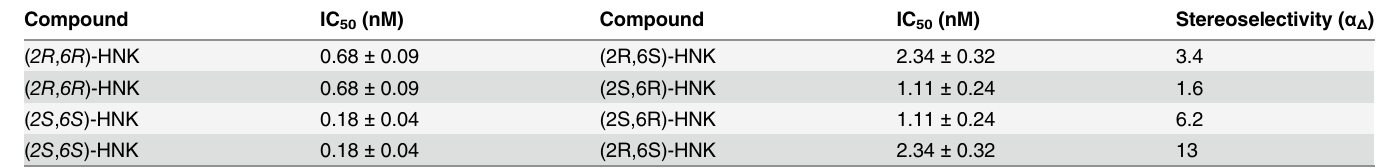
Table 2. The stereochemical configurations at the C2 and C6 carbons of hydroxynorketamine (HNK) affect the concentration-dependent decrease in intracellular D-Ser concentration in PC-12 cells. The relative pharmacological activity ( α D ) is derived by IC 50 ( trans -isomer)/IC 50 ( cis -isomer). The IC 50 values are expressed as means ± SD, n = 3 independent